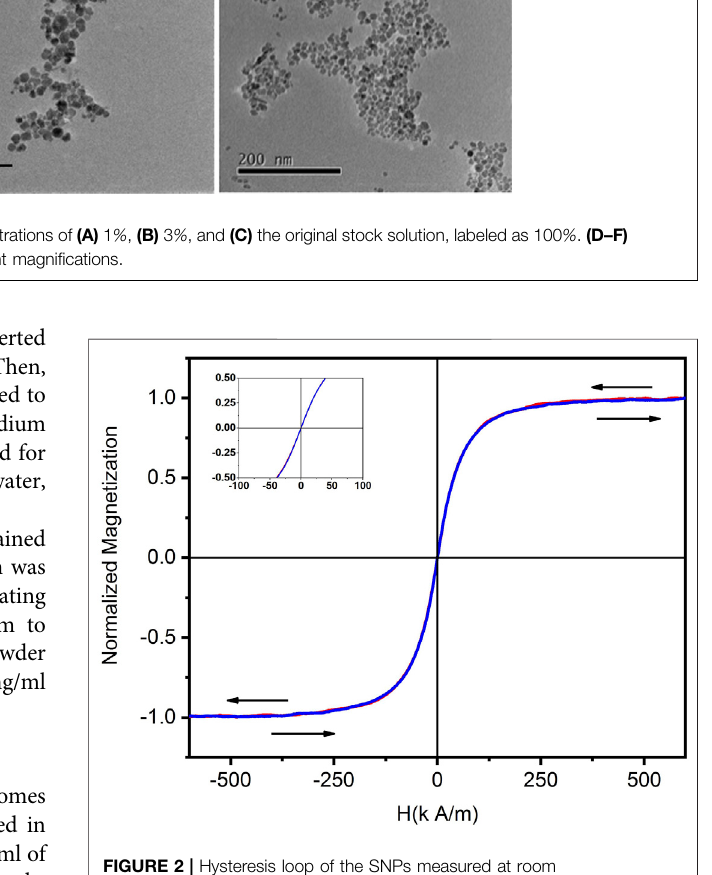
FIGURE 2 | Hysteresis loop of the SNPs measured at room temperature. The inset shows a magni fi cation near the zero fi eld, where a null coercivity con fi rms the superparamagnetic behavior of the